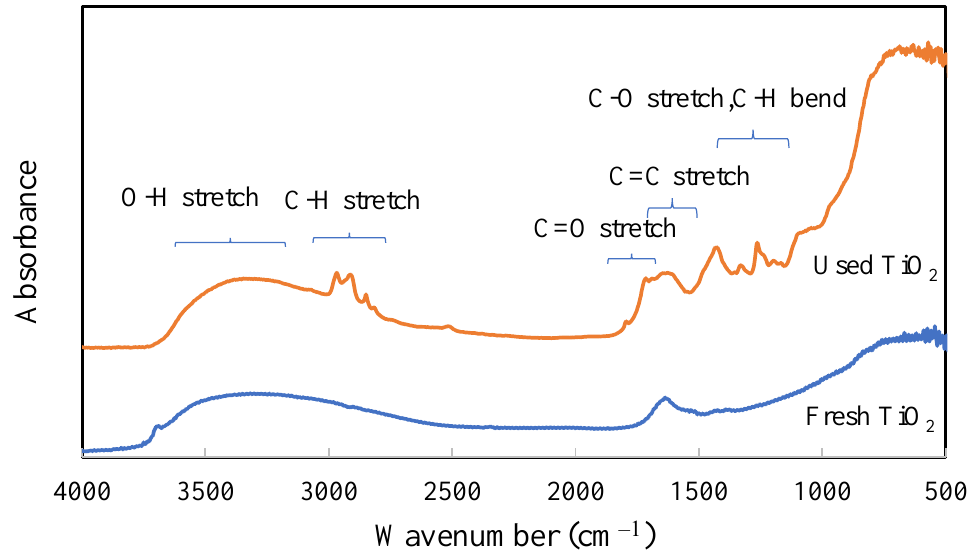
Figure 3. FTIR analyses of new (fresh) and used P25 TiO 2 . The used photocatalyst was taken from the UV LED device following experimental trials with benzene.